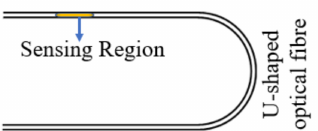
Figure 2. Schematic of a U-shaped fiber